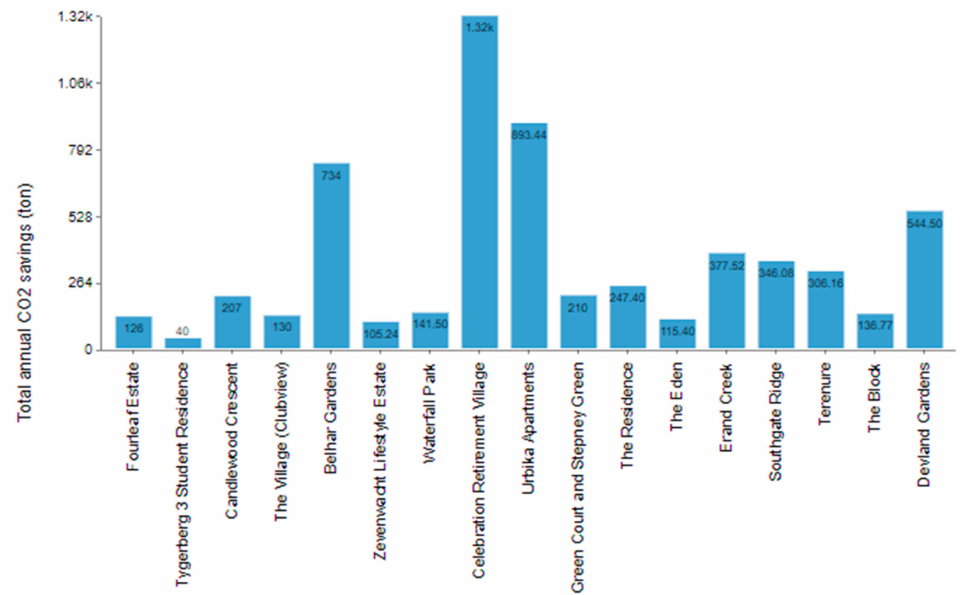
Figure 4. Total CO 2 savings (annually (ton) of the 17 South African residential complexes with EDGE